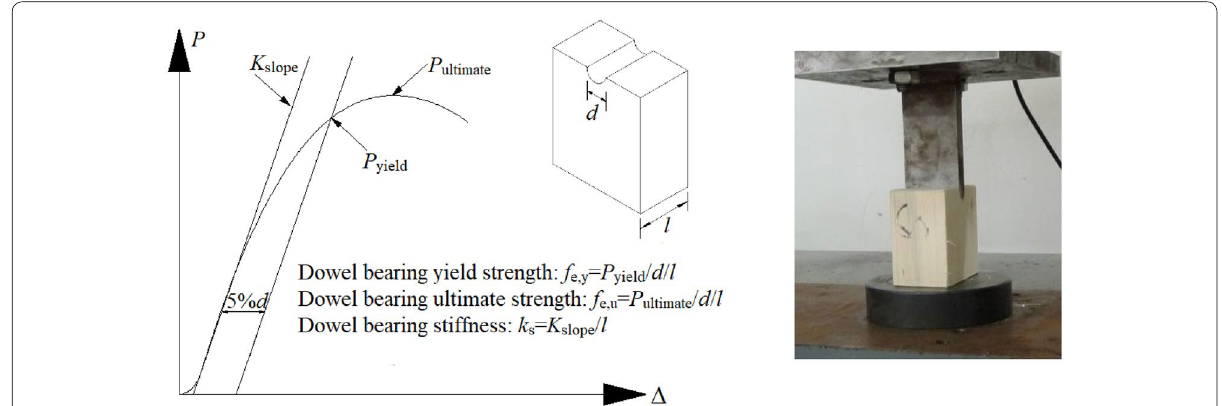
Fig. 12 Dowel bearing test of the